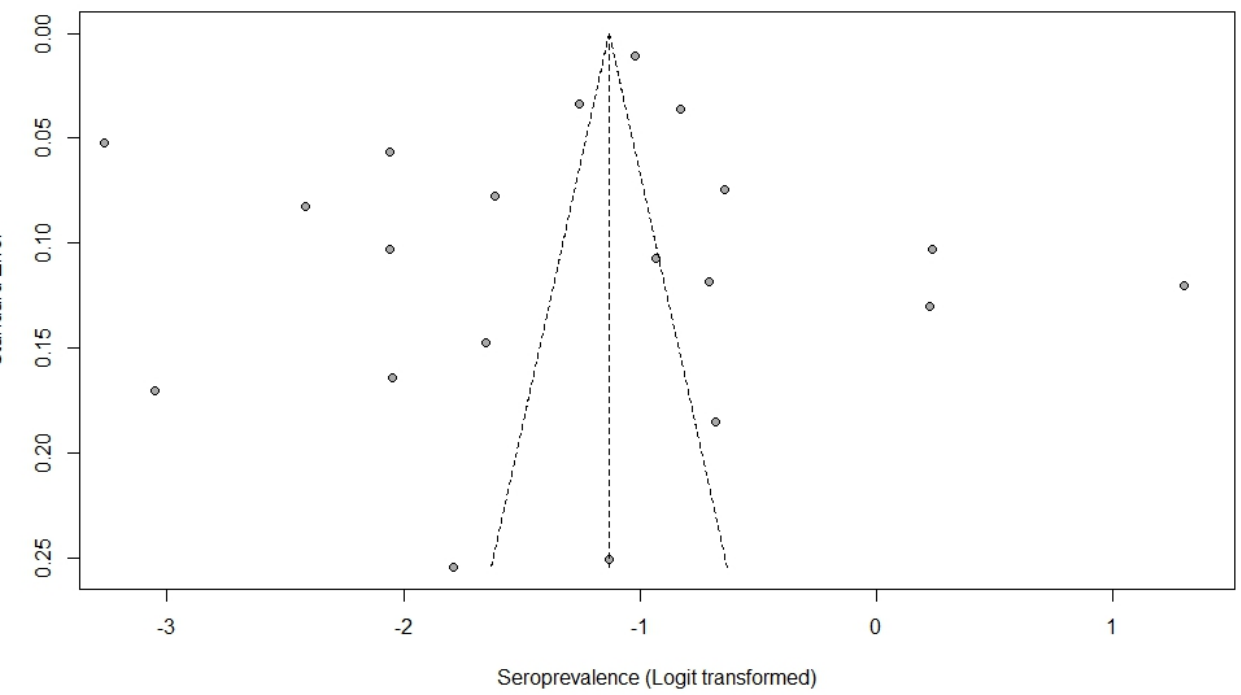
Figure 3. Funnel plot showing the distribution of studies (points) according to prevalence and stand- ard errors. standard